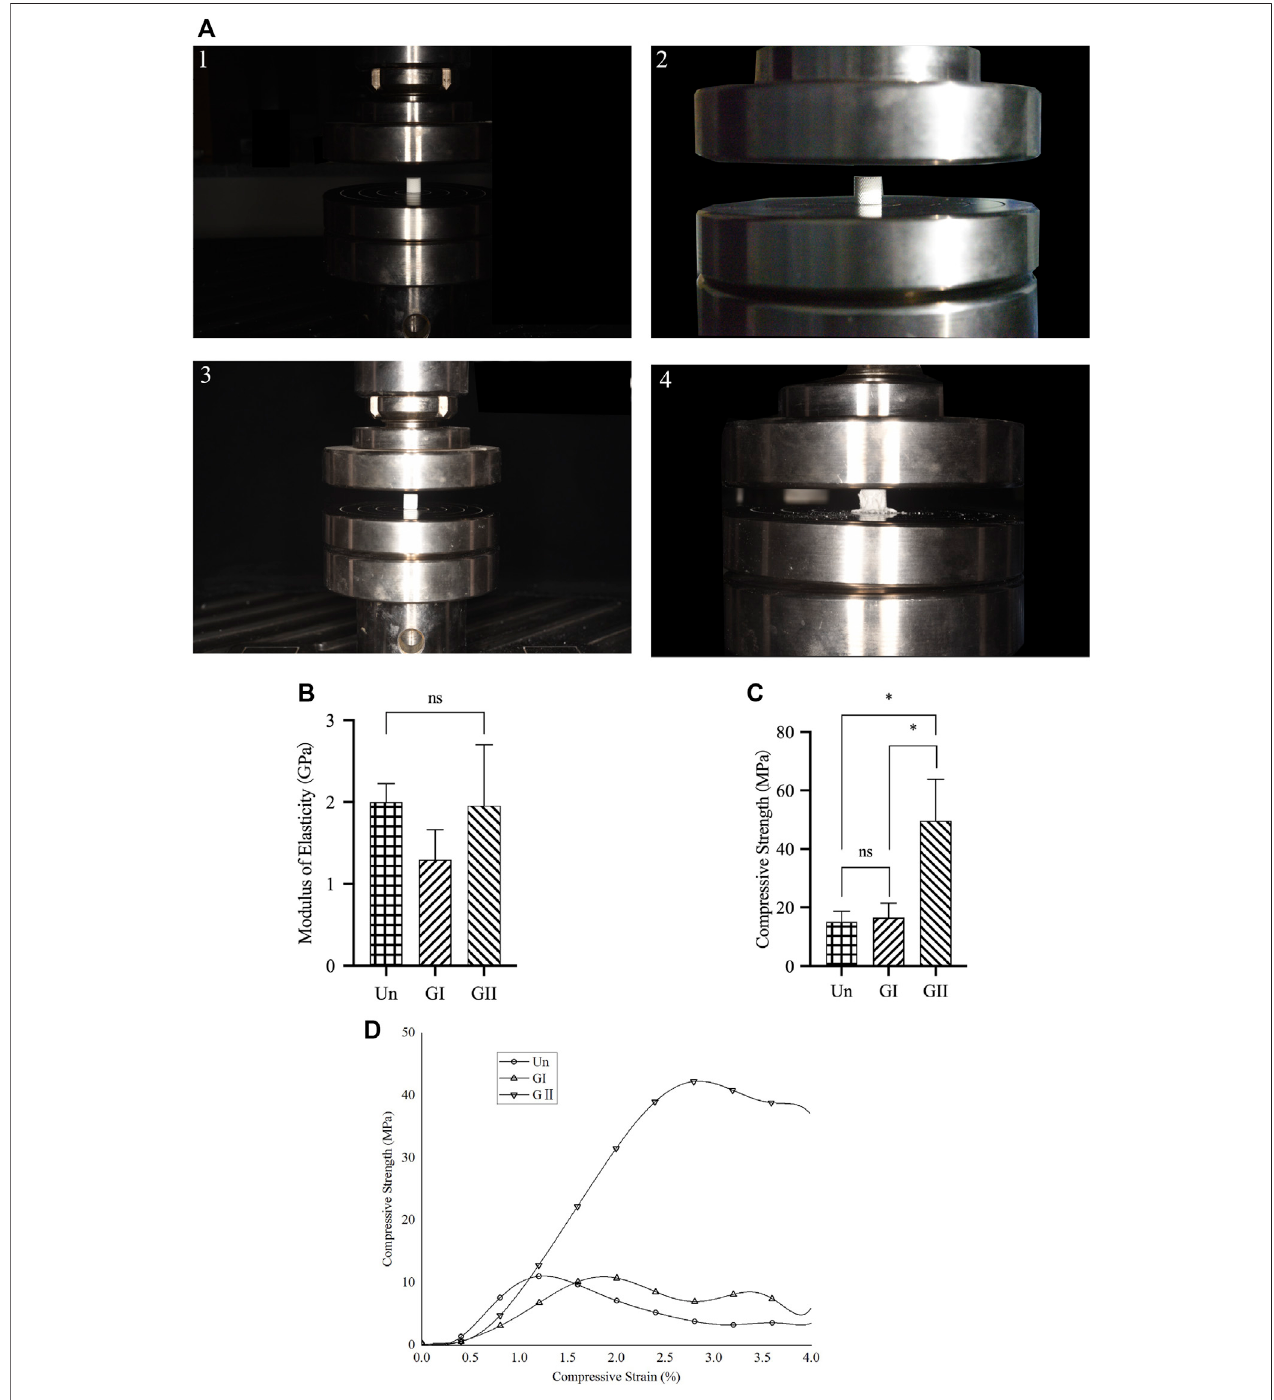
FIGURE 2 | Compression test of porous scaffolds. (A) The process of compression testing. (B) The elastic modulus of porous scaffolds. (C) The compression strength of porous scaffolds. (D) Stress strain relationship of porous scaffolds.